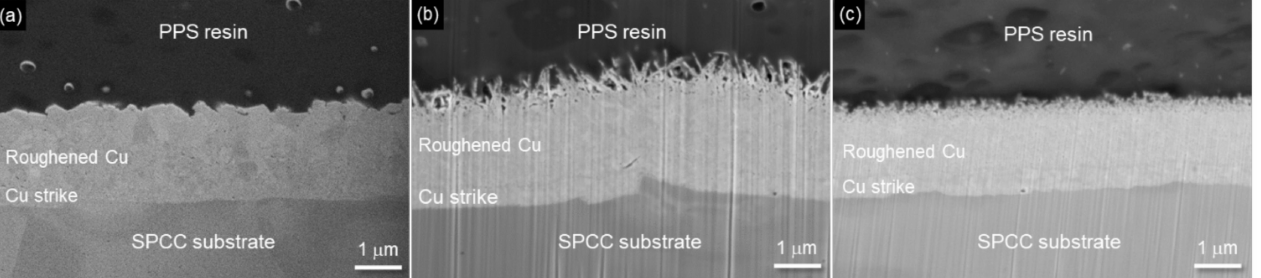
Figure 6. Cross-sectional SEM images of different bonded samples before the shear strength test: ( a ) Sample B; ( b ) Sample C; ( c ) Sample